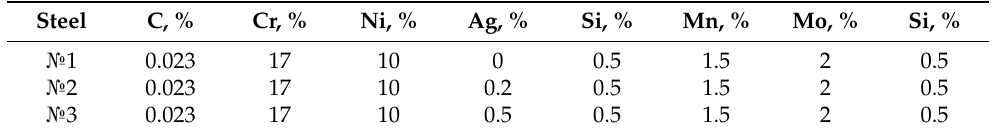
Table 1. Chemical composition of